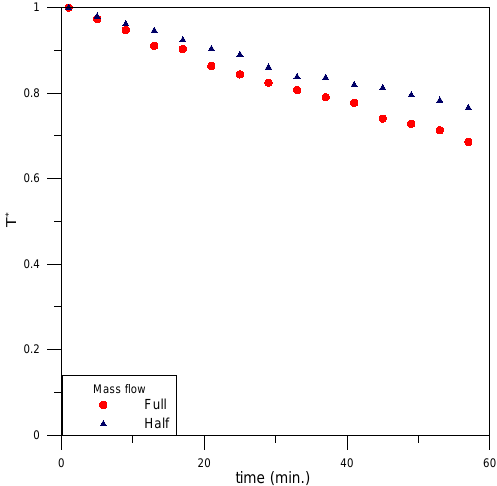
Figure 9. Comparison of efficiency between vertical vs. horizontal coil.